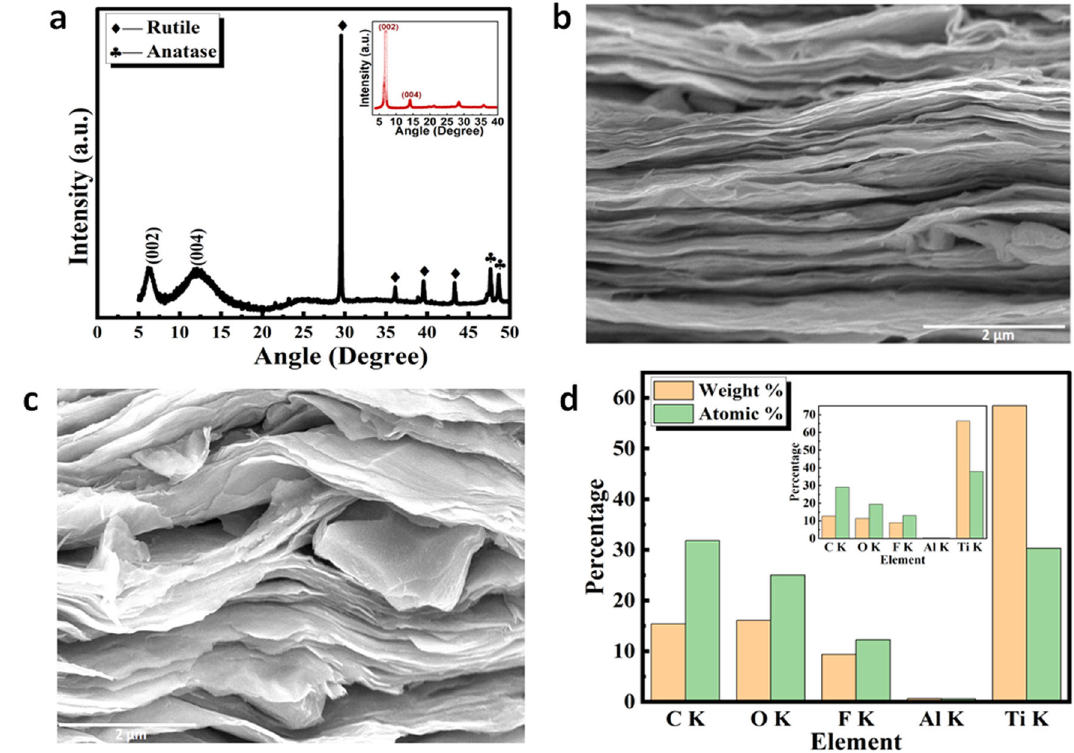
Fig. 1 Structural and morphological characterizations. a XRD pattern of HT-Ti 3 C 2 T x MXene fi lm (inset: Ti 3 C 2 T x MXene fi lm). b SEM image of